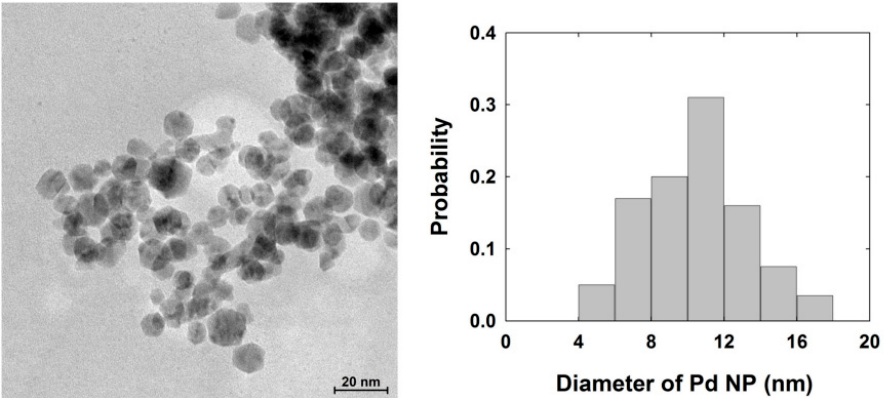
Figure 1. Transmission electron microscopy (TEM) image of palladium (Pd) nanoparticle (NP) and its size distribution. The scale bar is 20 nm. size distribution. The scale bar is 20